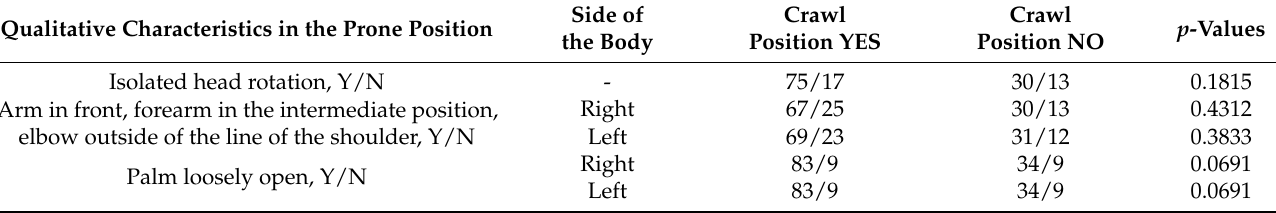
Table 2. The difference between children who achieved ( n = 92) or not ( n = 43) in the crawl position in the 7th month in the performance (Y/N) of 15 elements of the qualitative characteristics in the prone position in the 3rd month of life. Exact p -value was